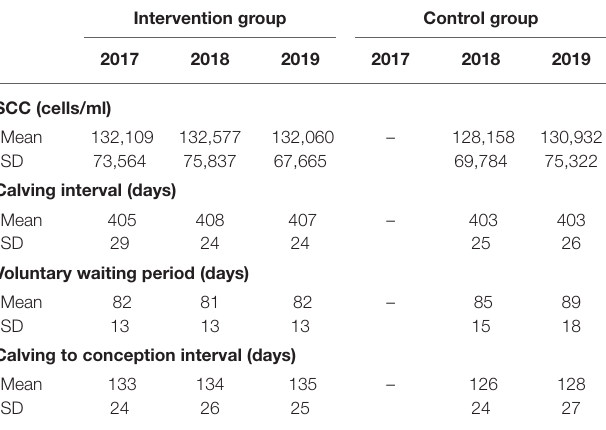
TABLE 6 | Description of animal health data of the intervention and control group. Intervention group Control